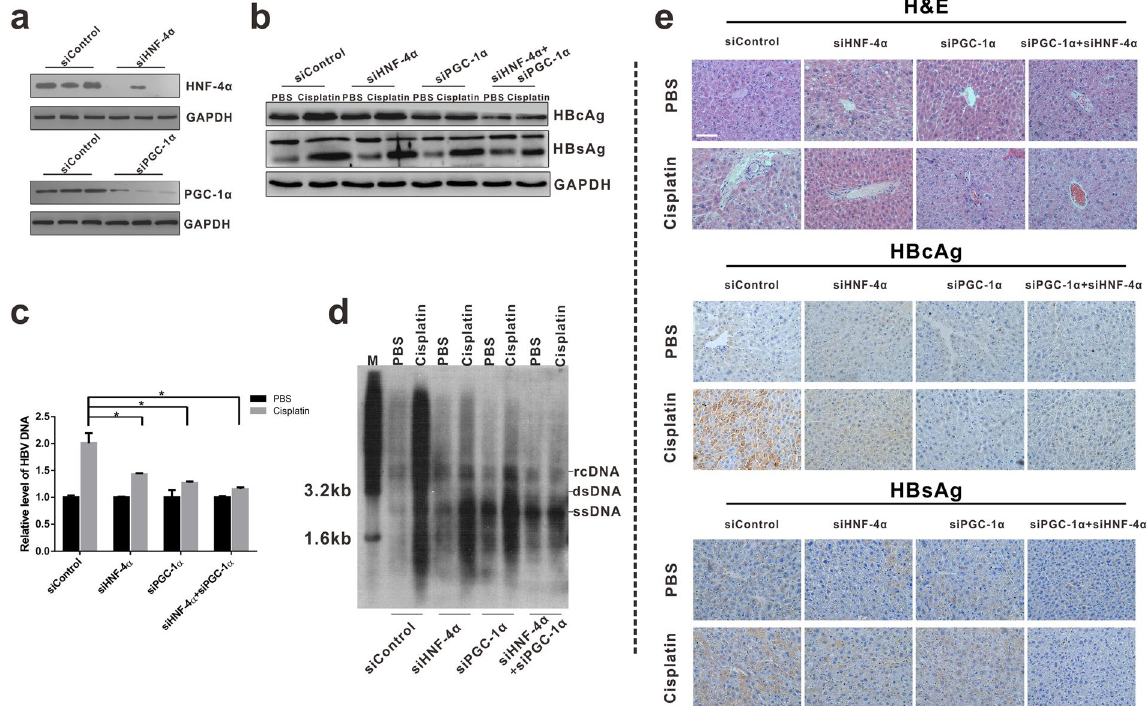
Figure 4. HNF4 α and PGC1 α ablation reduces cisplatin-induced HBV reactivation in HBV transgenic mouse model. The HBV transgenic mice (Background C57 BL/6 J) were randomly divided into eight groups (n = 6 for each group). Mice received 6.0 mg/kg cisplatin or PBS control daily for 5 days. On the sixth day, the mice were sacrificed and serum and tissue samples were collected. For siRNA experiments, adenoviruses AdR-siHNF4 α , AdR-siPGC1 α alone, or AdR-siHNF4 α + AdR-siPGC1 α were administered via the tail vein 24 h prior